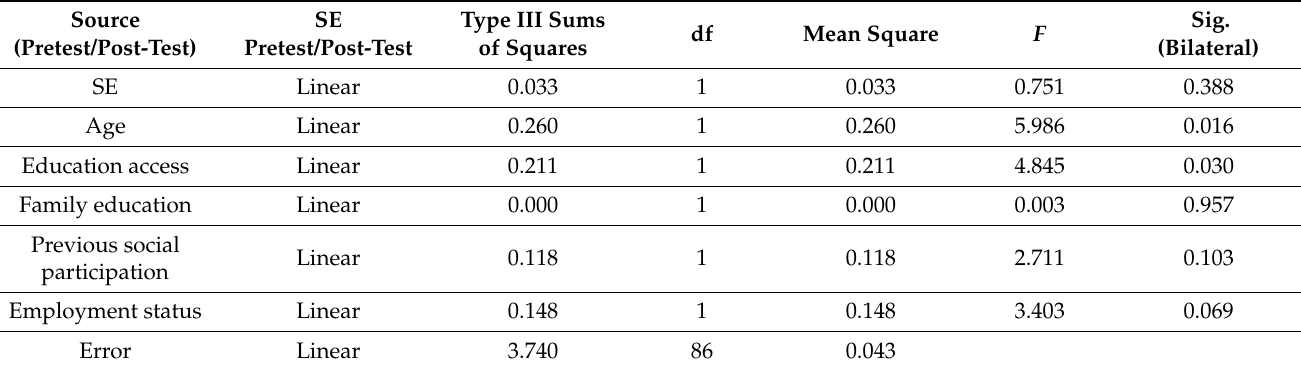
Table 4. Tests of within-subject contrasts SE